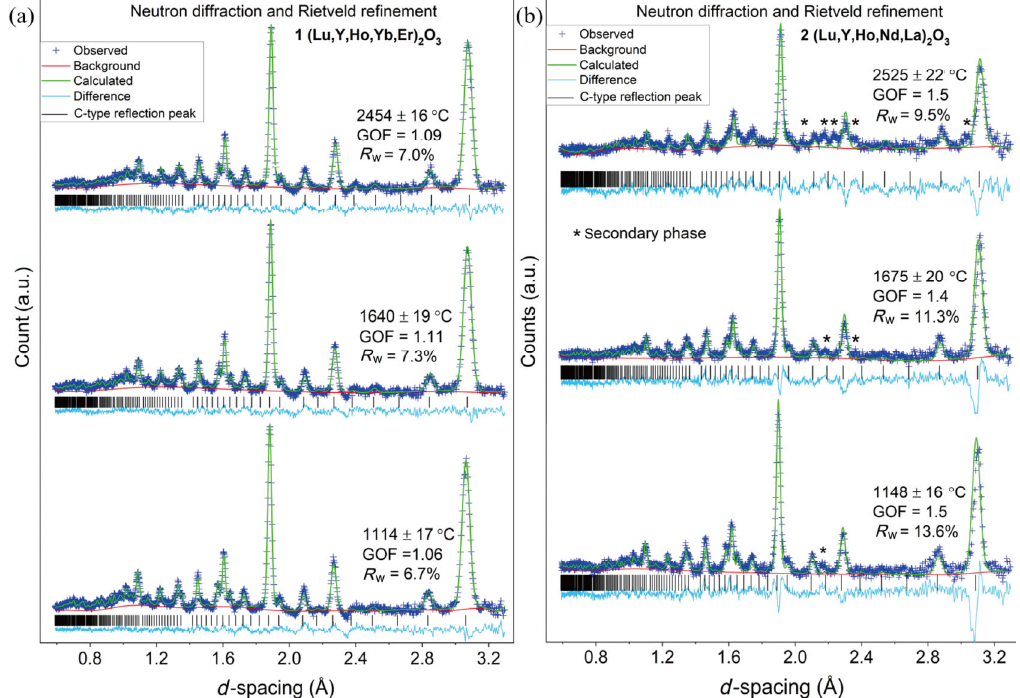
Fig. 3 In-situ high-temperature neutron diffraction data and Rietveld refinement results for beads of (a) composition 1 (Lu,Y,Ho,Yb,Er) 2 O 3 and (b) composition 2 (Lu,Y,Ho,Nd,La) 2 O 3 . Sample temperature is indicated in each pattern. The bead of composition 1 is a single C-type phase, and the bead of composition 2 is a mixture of a primary C-type phase with an unknown secondary phase. Goodness-of-fit (GOF) values are included in Fig.